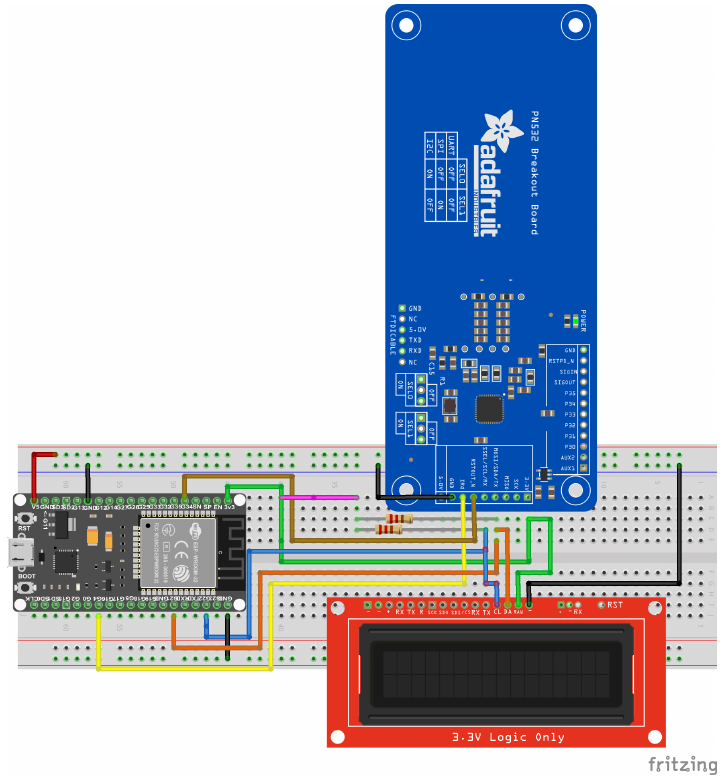
Figure 5. The door entry node (breadboard